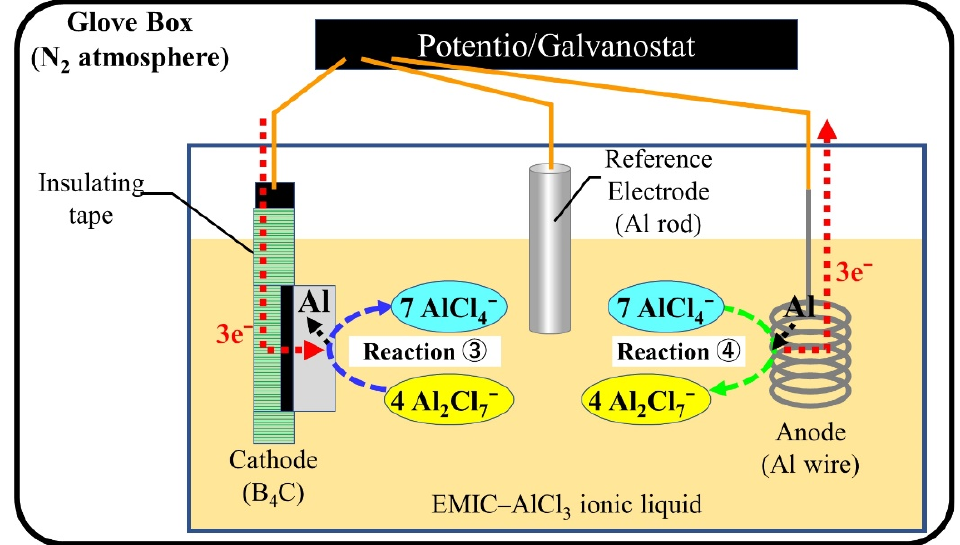
Figure 1. Schematic diagram of the Al electroplating process using EMIC–AlCl 3 ionic